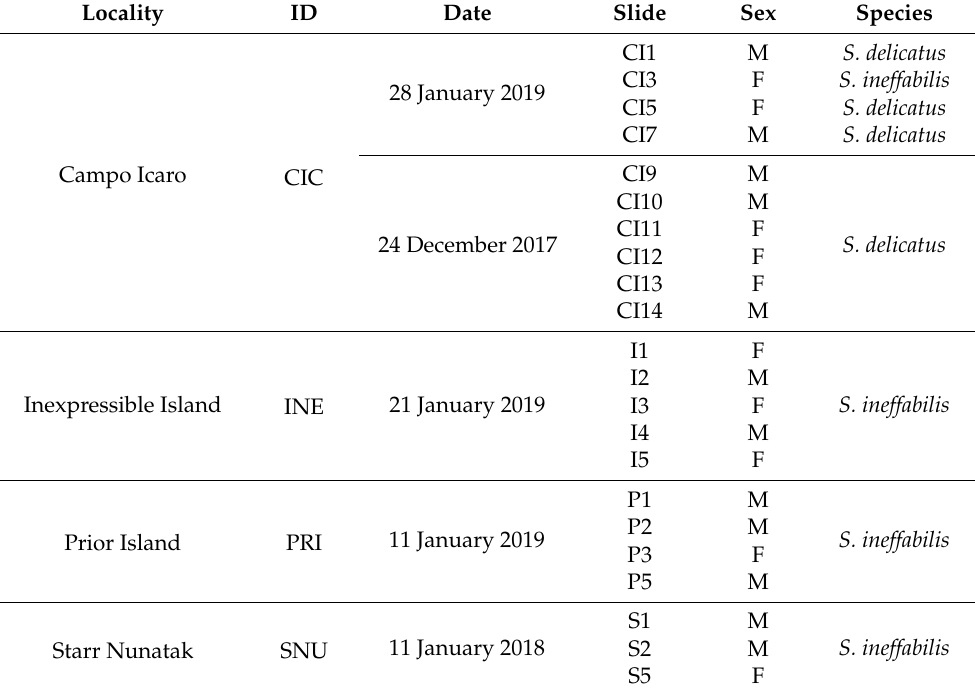
Table 2. New specimens extracted for the haplotypic and morphological analyses. Sampling localities with their ID codes, date of collection and the slide codes, and the sex and species of the new Stereotydeus individuals are given.